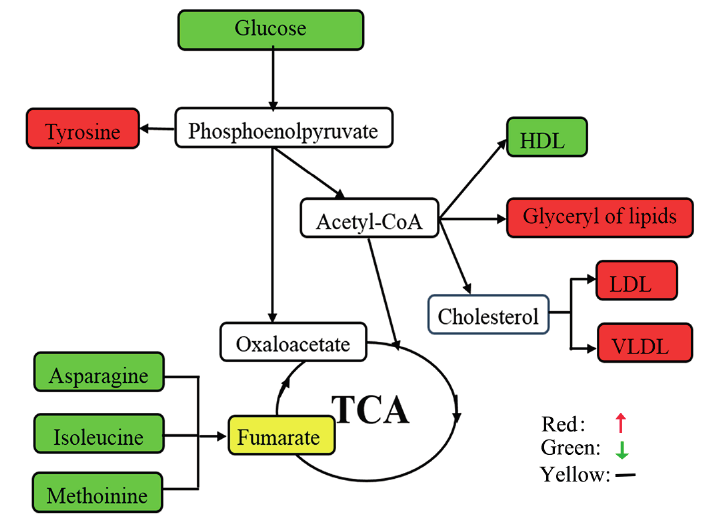
Figure 6. Schematic overview of the metabolite changes in fluoxetine-treated astrocytes. The metabolites are shown in color: red represents increased metabolites; green represents decreased metabolites; yellow represents no change; and the open box represents no detected metabolites. TCA, tricarboxylic